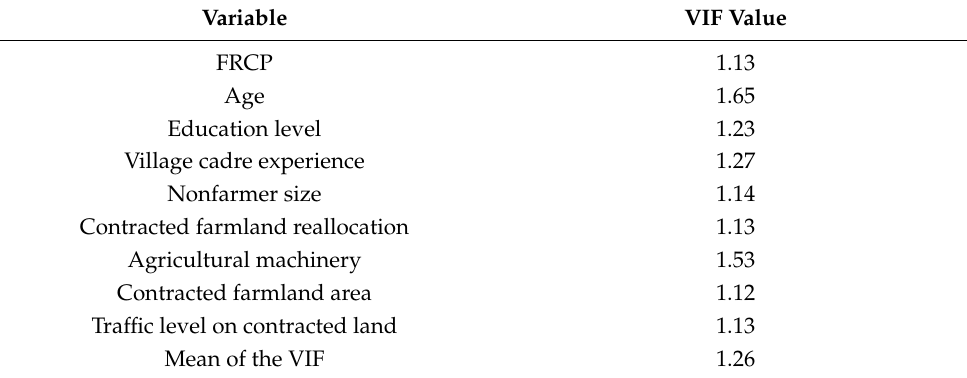
Table 2. VIF value test results of independent